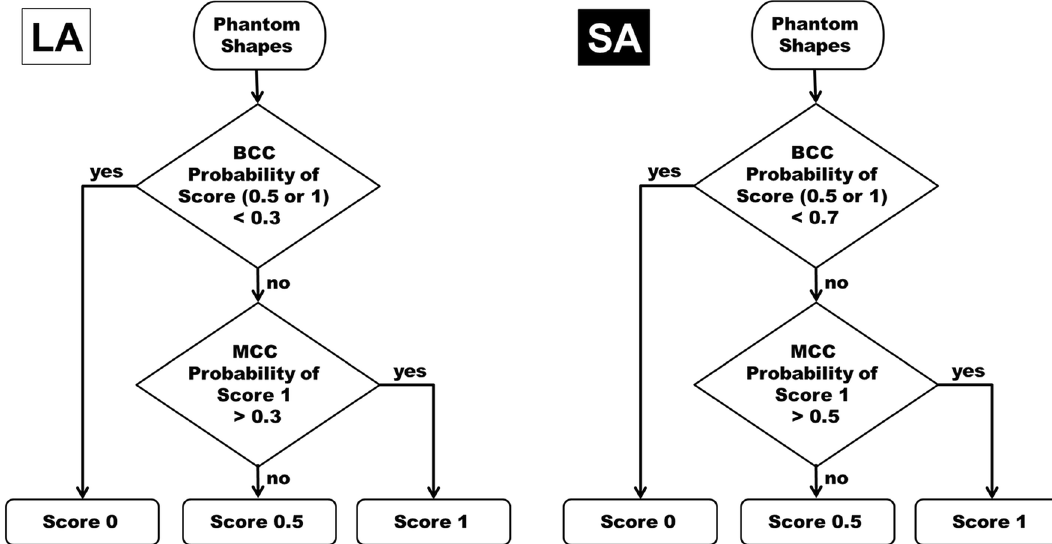
Figure 6. The final lenient algorithm (LA) and strict algorithm (SA) based on deep neural network based phantom shape scoring (DPS) models. Specific thresholds for LA and SA are selected after trying various combinations of threshold values.